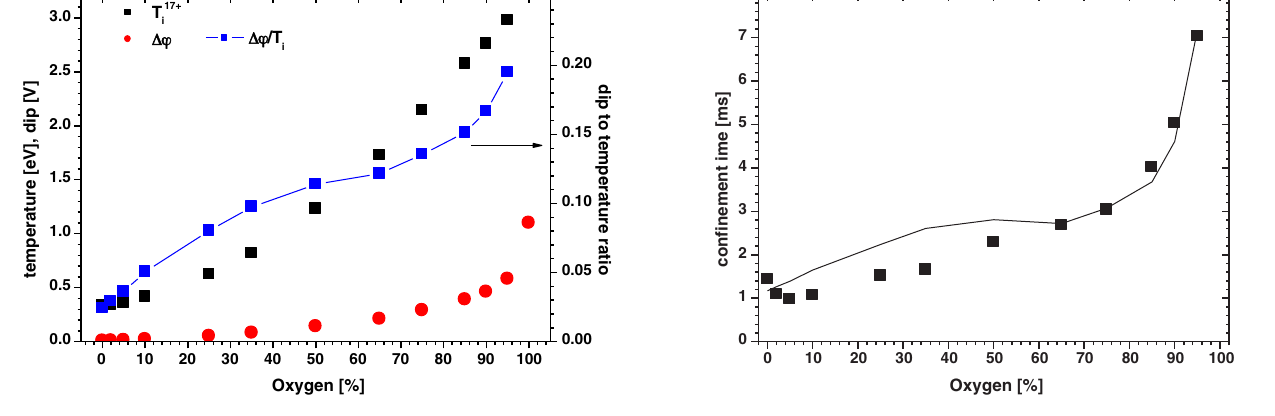
FIG. 6. Potential dip Δ φ (red circles, left scale), temperature of Kr 17 þ ions (black squares, left scale), and the ratio between these values (line with blue squares, right scale) for different oxygen contents.